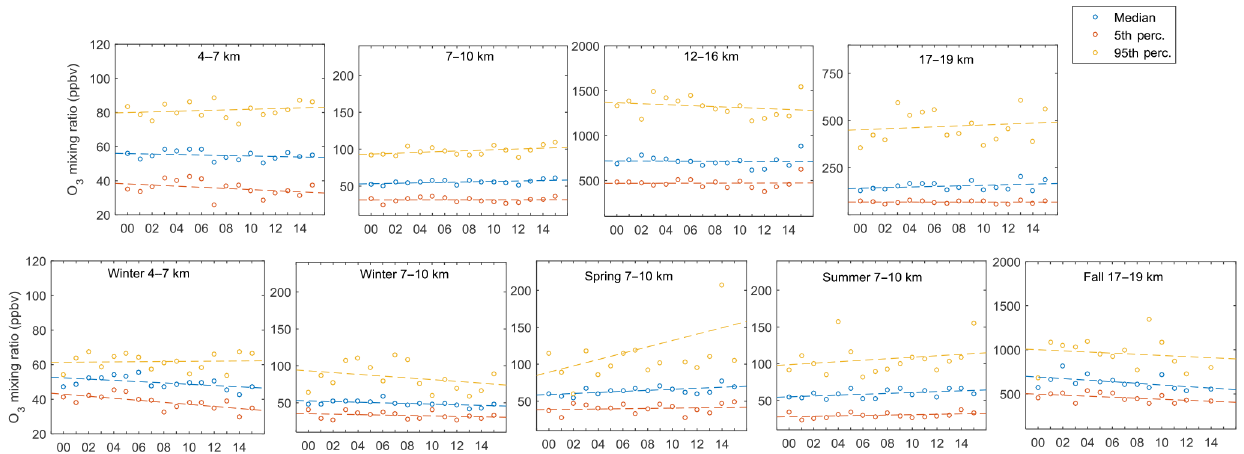
Figure 6. Time series of the median (blue), 5th (orange) and 95th (yellow) percentile ozone values at different altitude layers for the full year (top) and for selected seasons and altitude layers (bottom) obtained from the TMF lidar measurements. Dashed lines represent the linear fit for each time